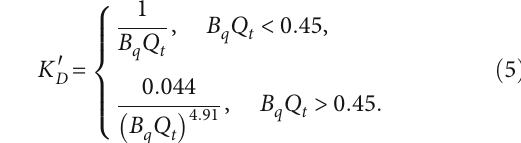
Figure 1: Relationship between measured nondimensional hydraulic conductivity K et al.